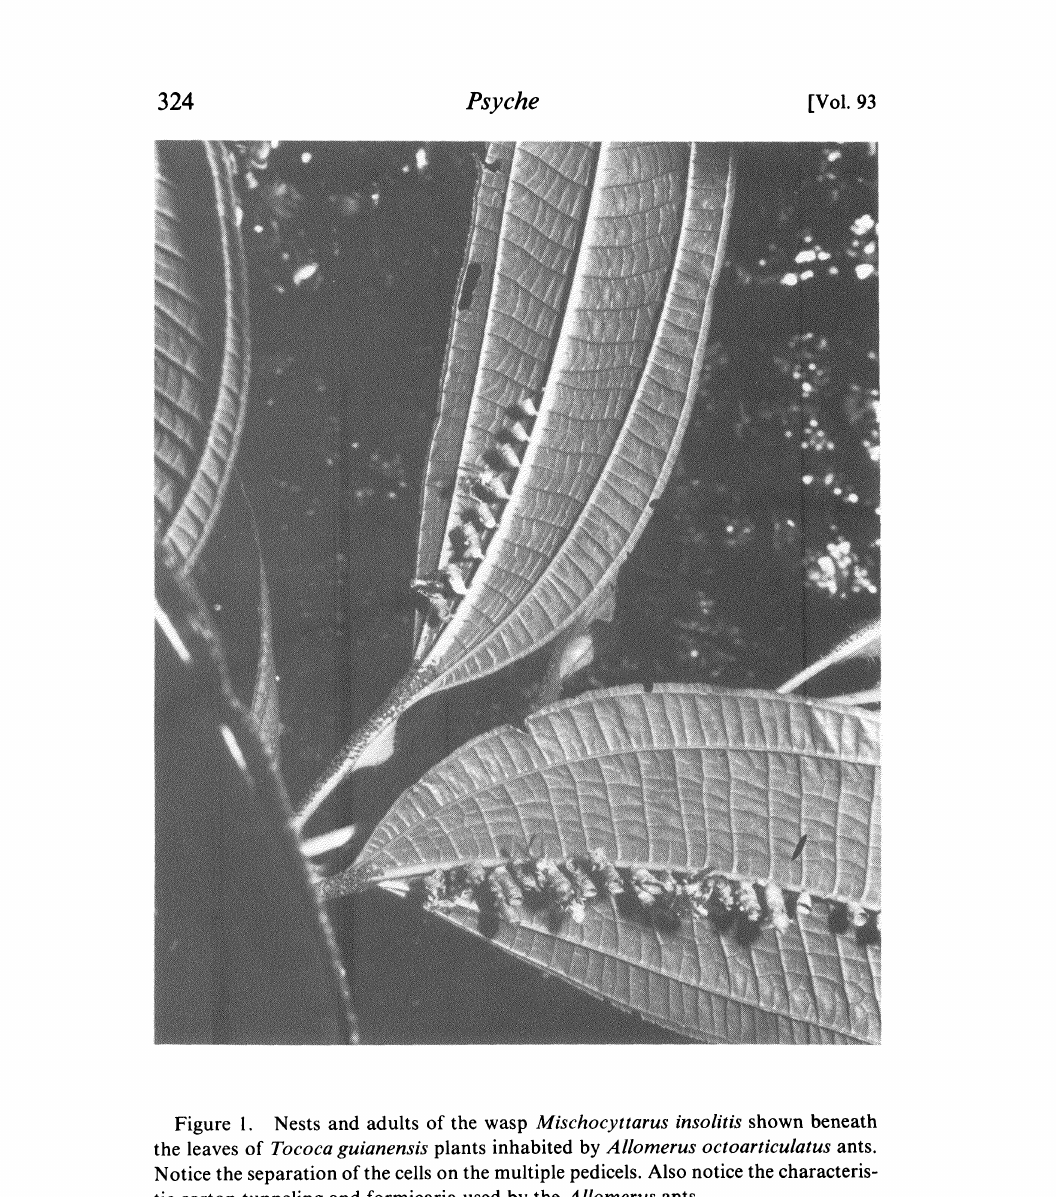
Figure 1. Nests and adults of the wasp Mischocyttarus insolitis shown beneath the leaves of Tococa guianensis plants inhabited by Allomerus octoarticulatus ants. Notice the separation of the cells on the multiple pedicels. Also notice the characteris- tic carton tunneling and formicaria used by the Allomerus